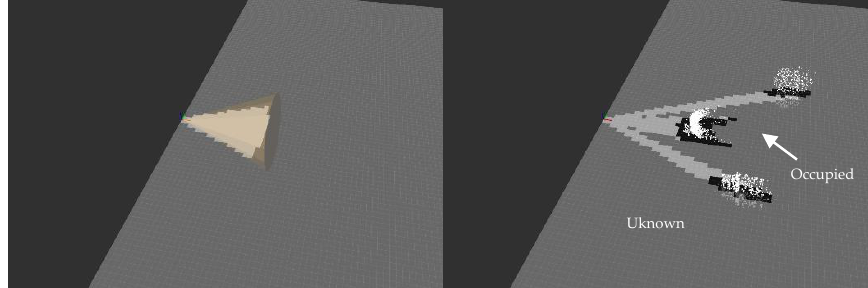
Figure 15. Ultrasound ( left ) and depth camera ( right ) measurements together with their respective occupancy grid computed with SigmaFusion™. The color of each cell encodes the occupancy probability (black: “occupied”; light grey: “empty”, grey: “unknown”).